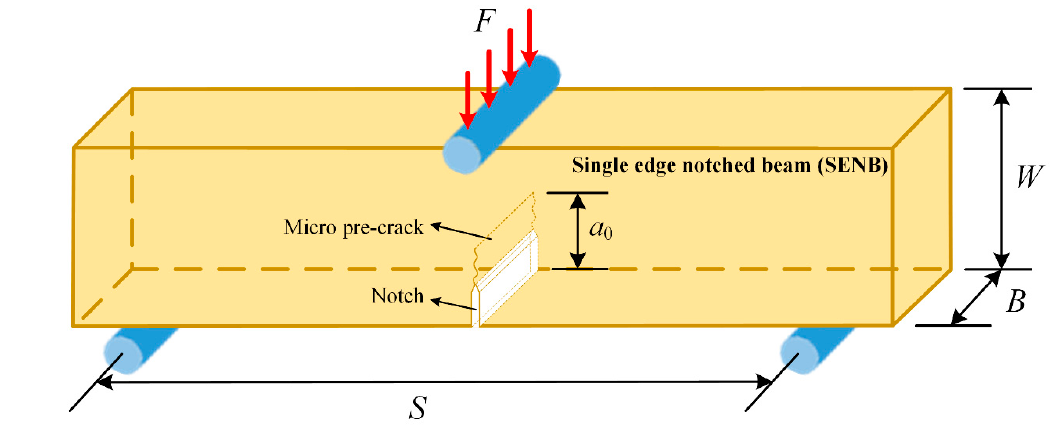
Figure 2. Three-point bending experiment of single edge notched beam (SENB).